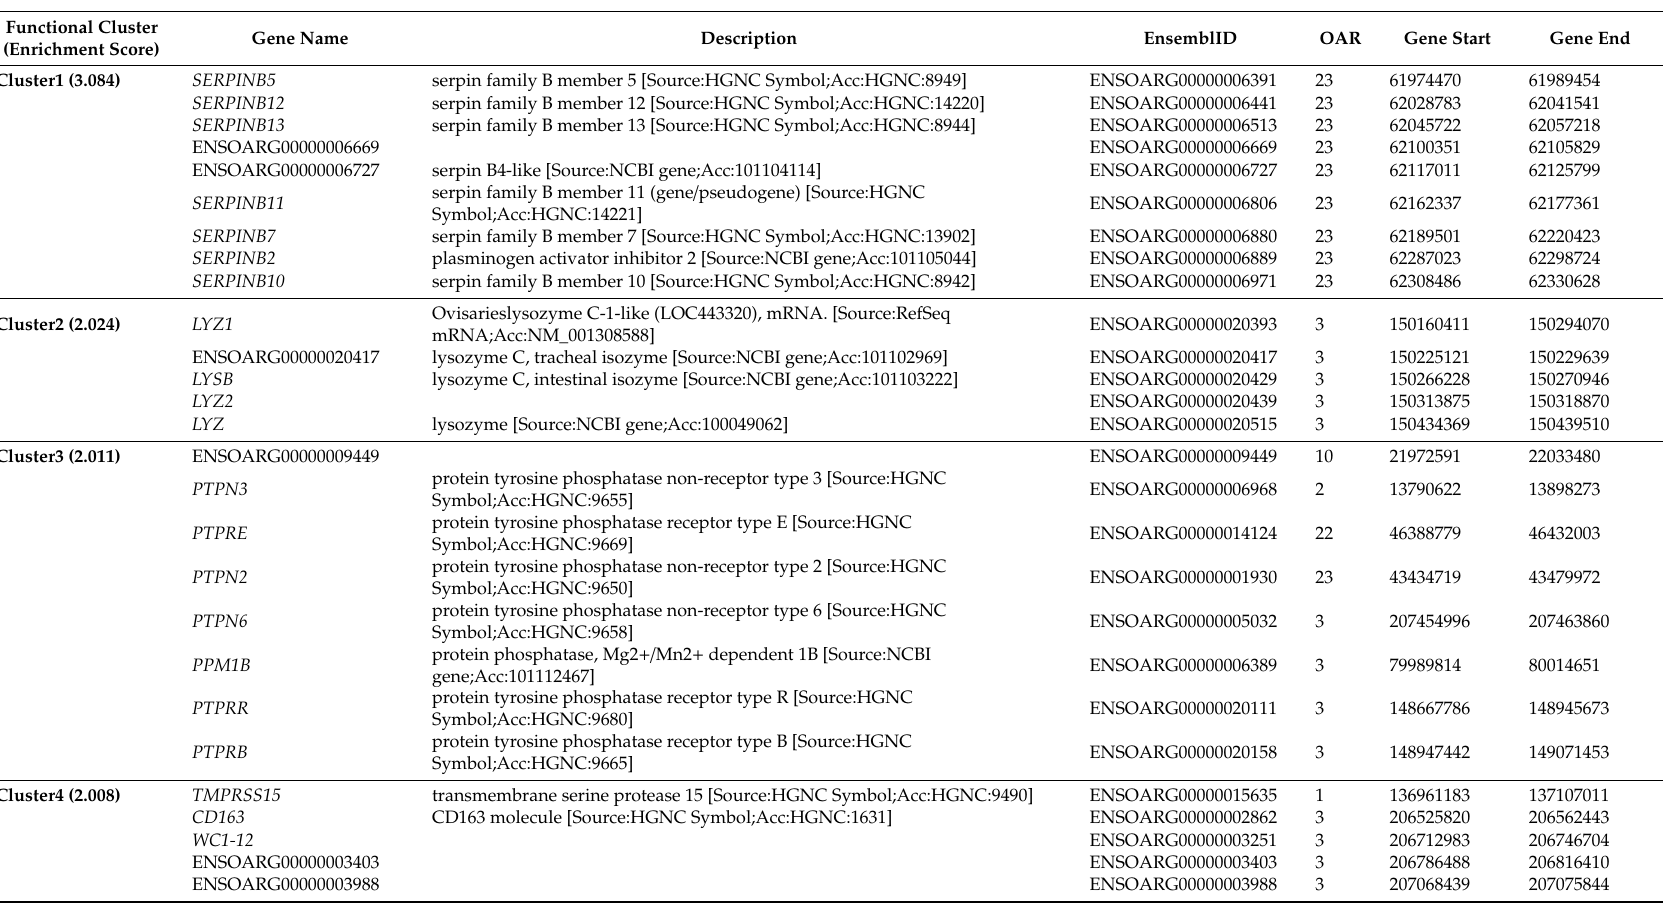
Table 2. Description of the sheep genes included in the six statistically significant functional clusters displaying enrichment score higher than 1.3.In addition to the gene name and description, the following information is provided: the identification of the gene retrieved from the Ensembl Genes 91 database, the ovine chromosome (OAR) on which the gene is located, and the positions (in bp) of start and end of the gene within the